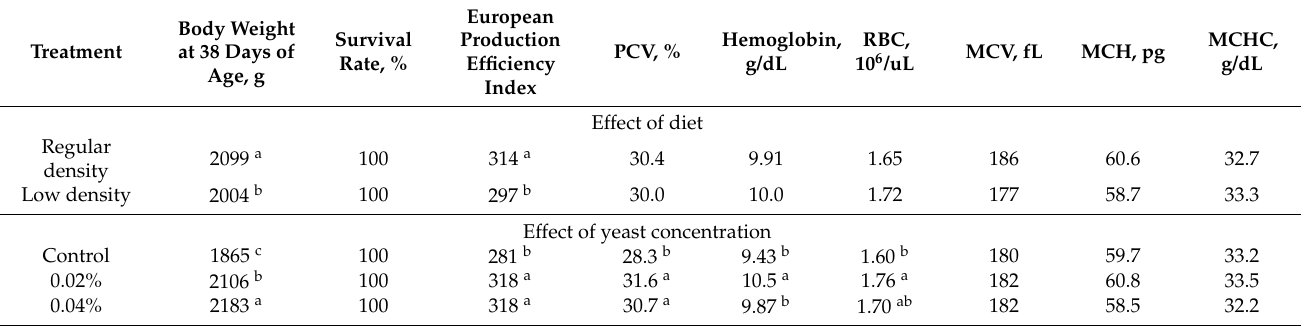
Table 2. Impact of different concentrations of Saccharomyces cerevisiae on body weight, survival rate, European Production Efficiency Index and blood hematological parameters of broilers fed regular- or low-density diets from days 1 to 38 of